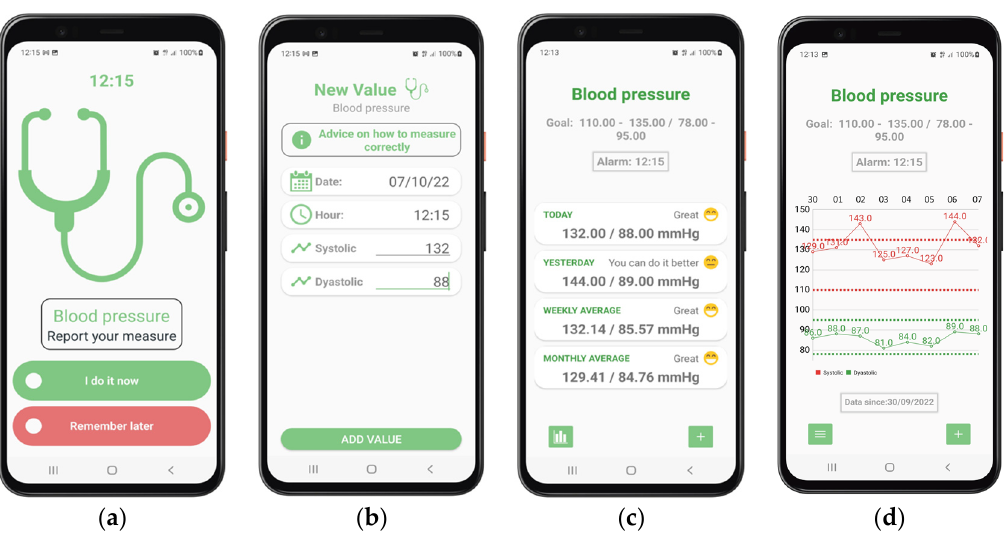
Figure 2. Some screenshots from the TeleHealth system—patient’s view (mobile app): ( a ) Blood pressure alarm; ( b ) Blood pressure data input; ( c ) Blood pressure evolution summary; ( d ) Blood pressure evolution detail. Higher-resolution screenshots are available as Supplementary Material.